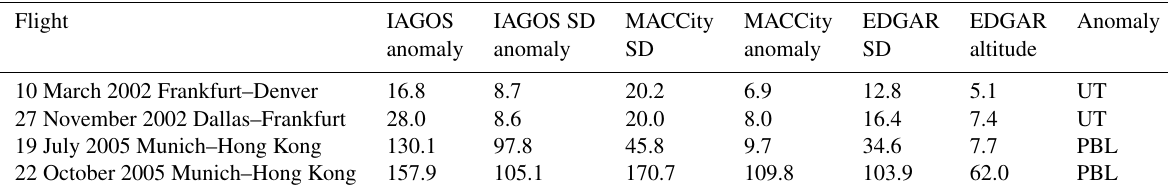
Table 3. Summary of the averaged observed and simulated anomaly and corresponding averaged standard deviation (SD) (in ppb) determined for representing anthropogenic emissions for different case studies (using GFAS v1.2 for biomass burning emissions). Altitude of the anomaly is indicated: planetary boundary layer (PBL) and upper troposphere